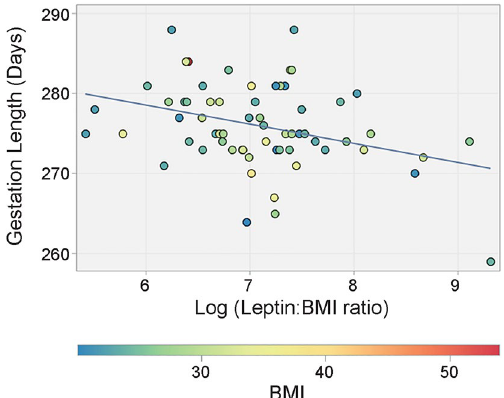
Figure 4. Relationship between mid-gestation serum leptin concentrations, adjusted for BMI, and total gestation length in days. The leptin:BMI ratio is log-transformed to achieve a normal distribution. For each individual, BMI is indicated by marker color.